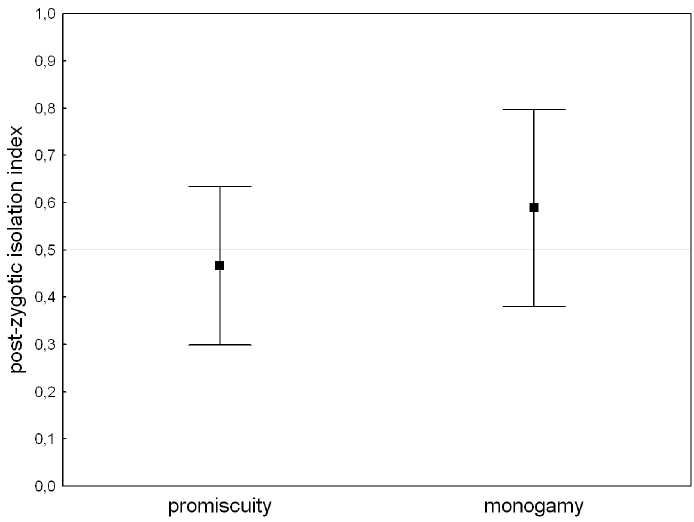
Figure 4. Mate choice and post-zygotic isolation indexes for monogamous and promiscuous mating system. Mean mate choice and post-zygotic isolation indices for monogamous and promiscuous mating system calculated from the mean indices for male lines. Indices values lower than 0.5 indicate that a female from the same line as a male produces on average more offspring than a female from a different line. Bars indicate 95% confidence intervals.